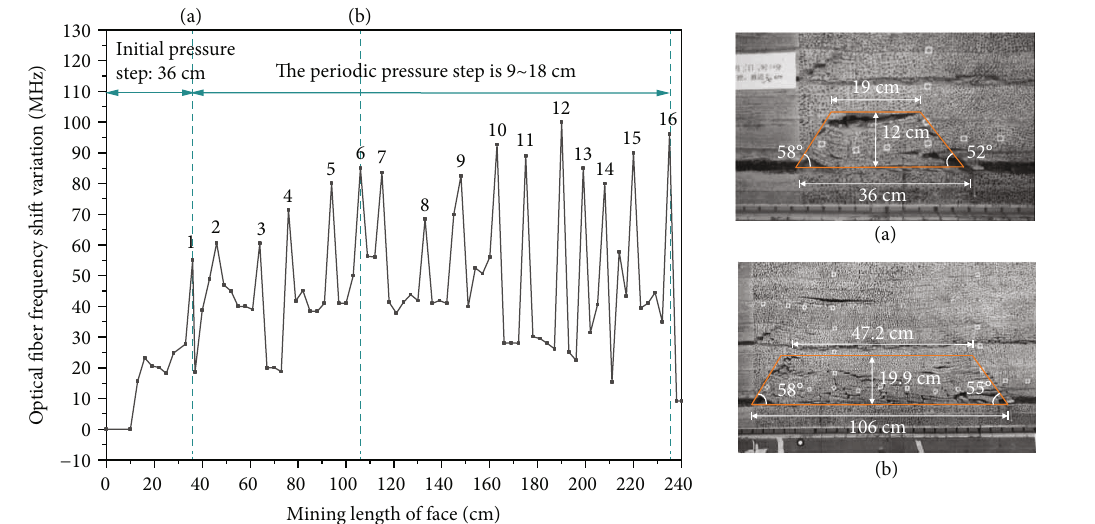
Figure 9: Impact pressure identi fi cation curve during the mining of the face of coal seam 2 -2 (the abscissa is the face excavation distance, and the ordinate is the variation degree of the optical fi ber frequency shift). (a) Face excavation distance of 36cm. (b) Face excavation distance of 106cm.